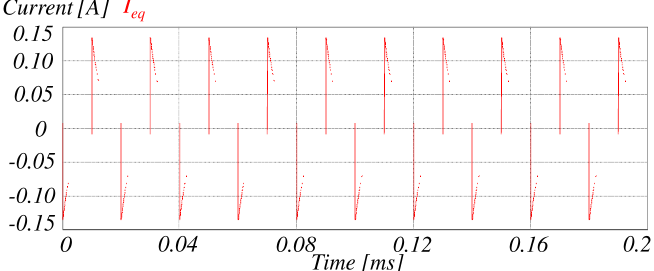
Figure 16. Zoom of the equalization current of the proposed converter operating in the RC-based